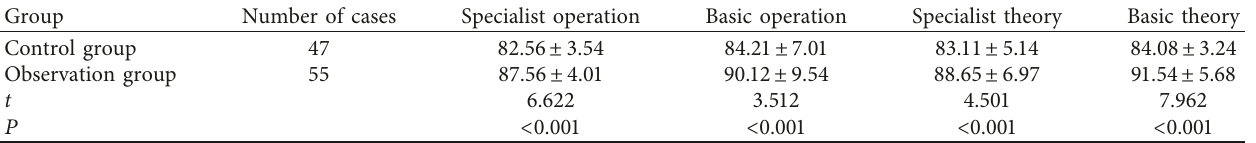
Table 2: Comparison of the comprehensive nursing quality ( n , x ± s , points).